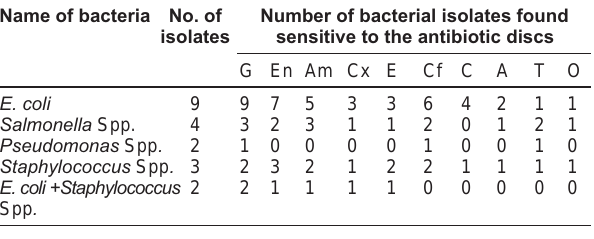
Table-2. Overall sensitivity and resistance profiles of of bacterial spp. isolated from canine pyometra